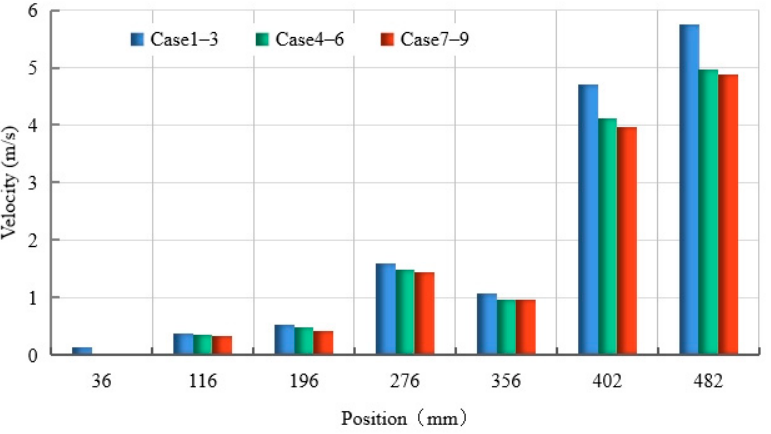
Figure 18. Location and wind speed distribution sequence of monitoring points.